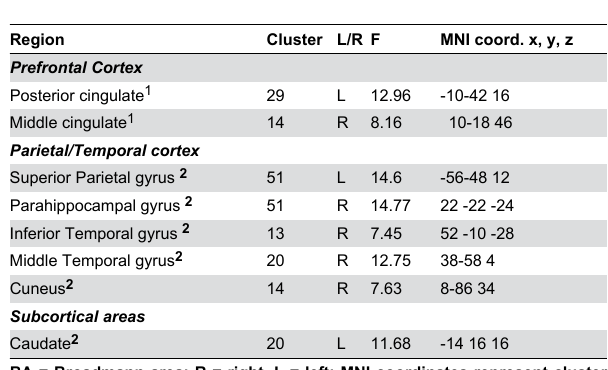
Table 8. Activations resulting from the Ustop >Sstop Error contrast One-way ANOVA (p <.005, k ≥ 13 voxels).